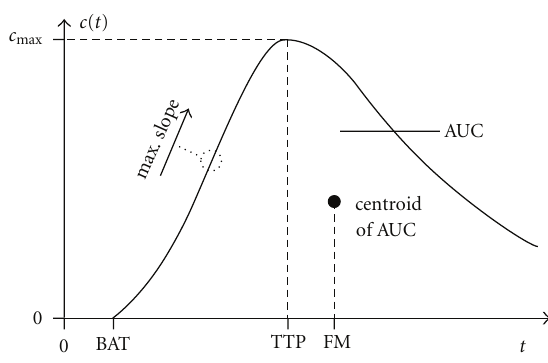
Figure 5: Perfusion parameters that are measured directly using the time-concentration curve. See Sections 3.5 and 4.1 for explanations (BAT: bolus arrival time, TTP: time-to-peak, FM: first moment, AUC: area under the